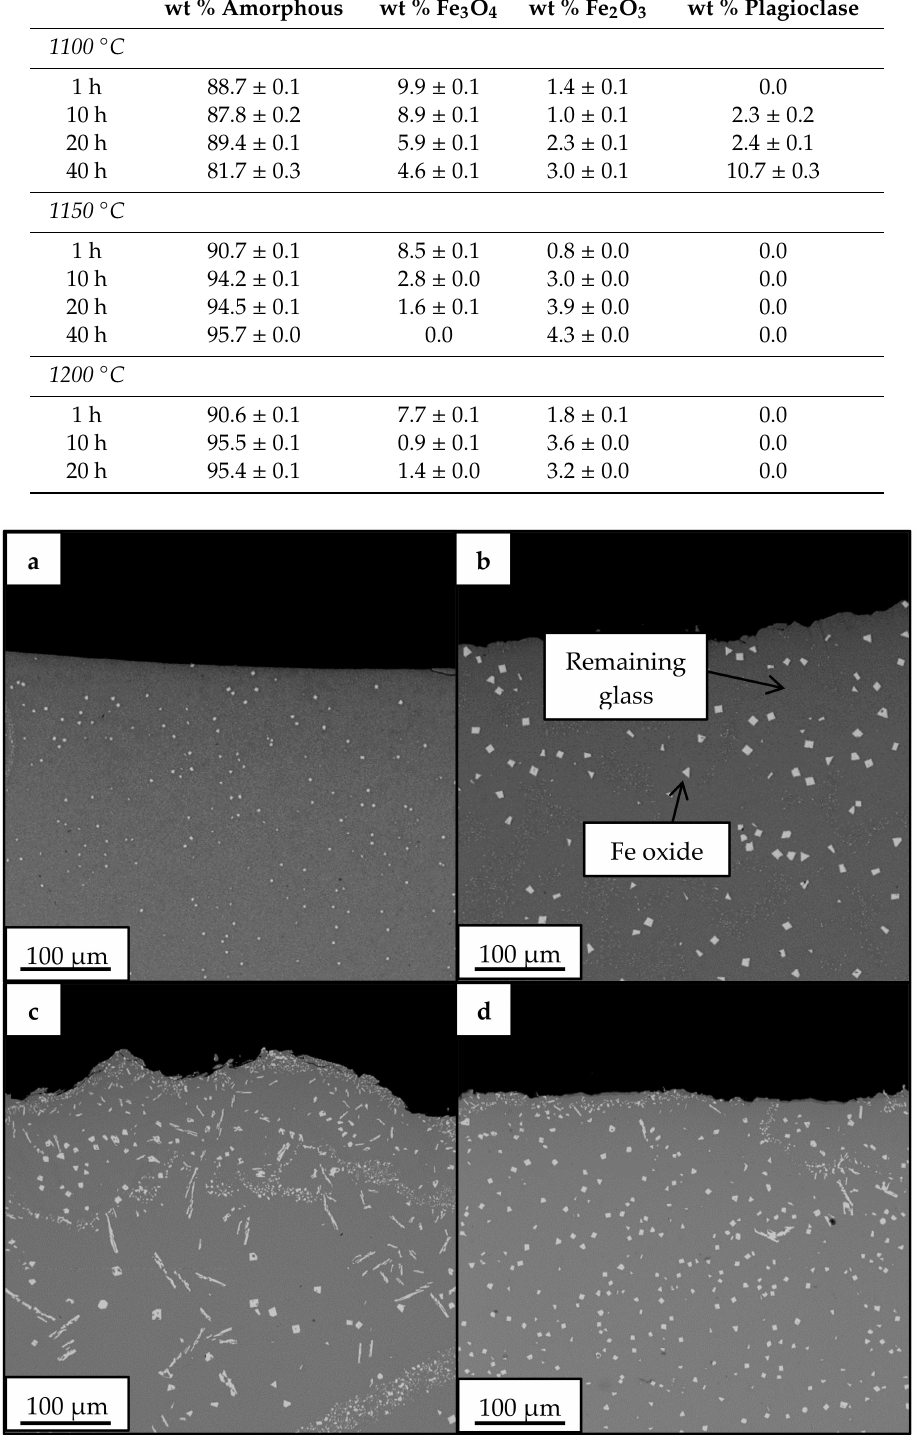
Figure 5. Cross-section backscattered electron imaging (BSE) images of bulk volcanic ash glass after exposure at 1150 ◦ C for 1 h ( a ), 10 h ( b ), 20 h ( c ), and 40 h ( d